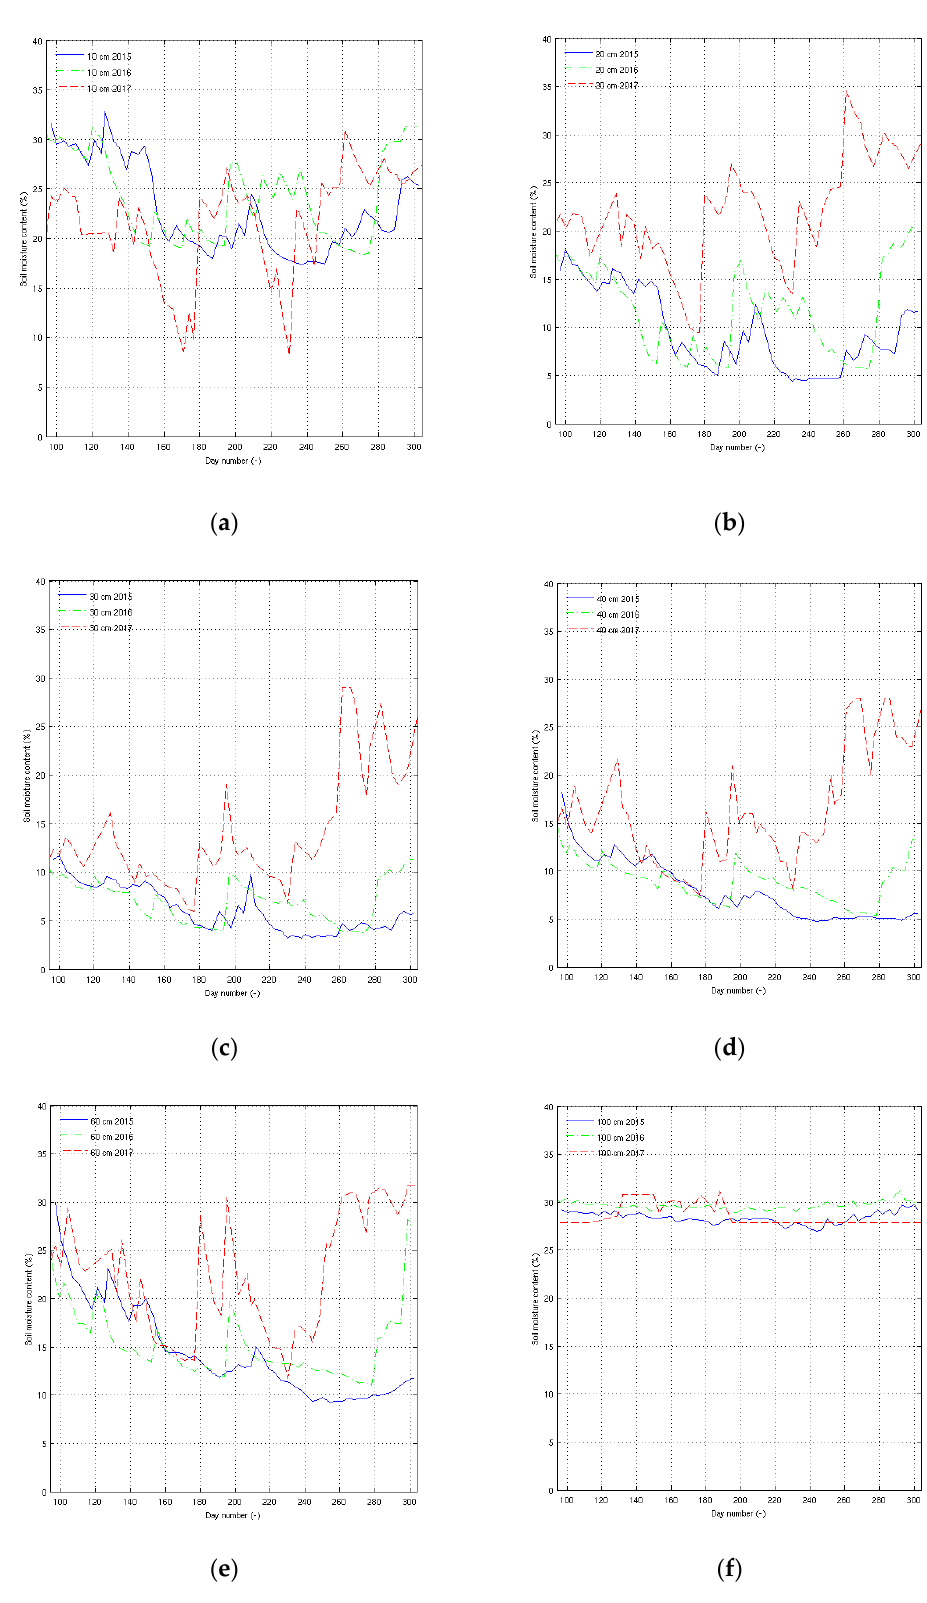
Figure 7. Measured temporal distribution of the soil moisture content at a depth of: ( a ) 10 cm; ( b